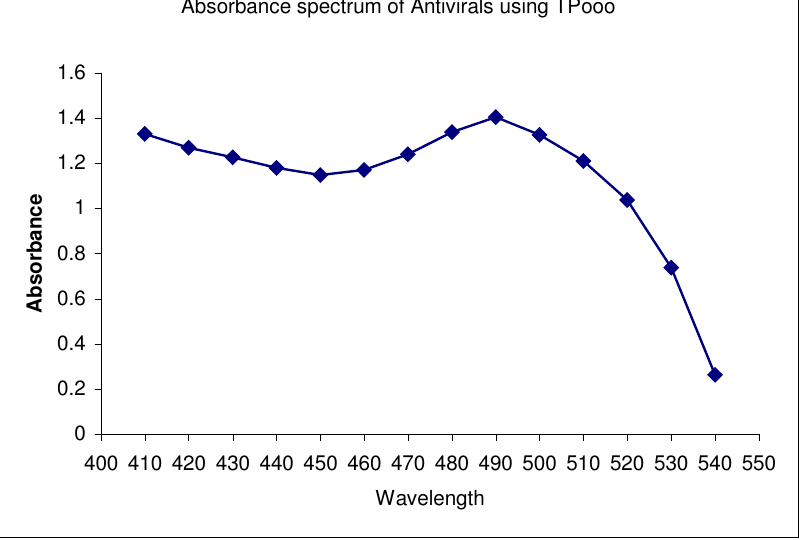
Absorbance spectrum of Antivirals using